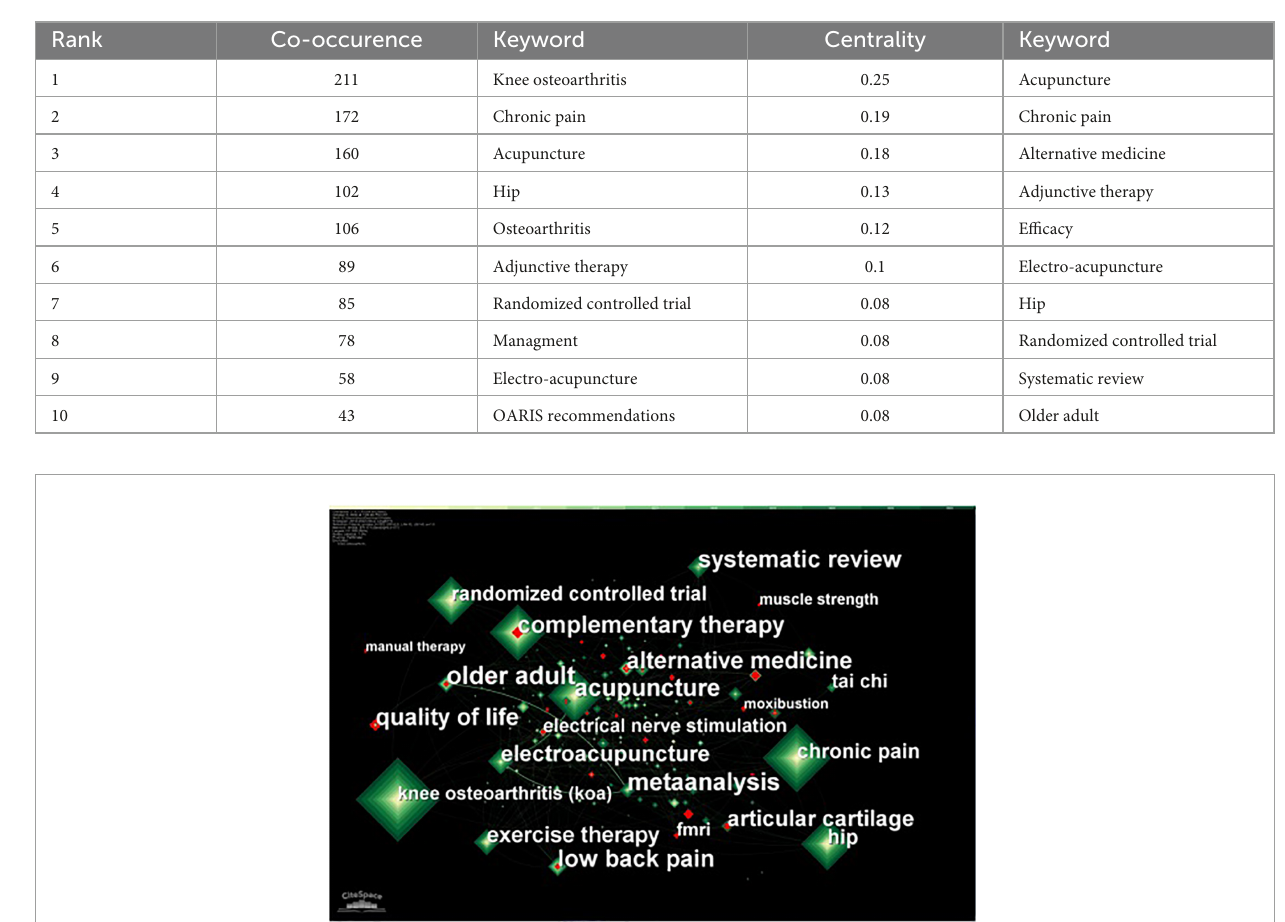
TABLE 8 Top 10 keywords related to Chinese non-pharmacological therapy on KOA.